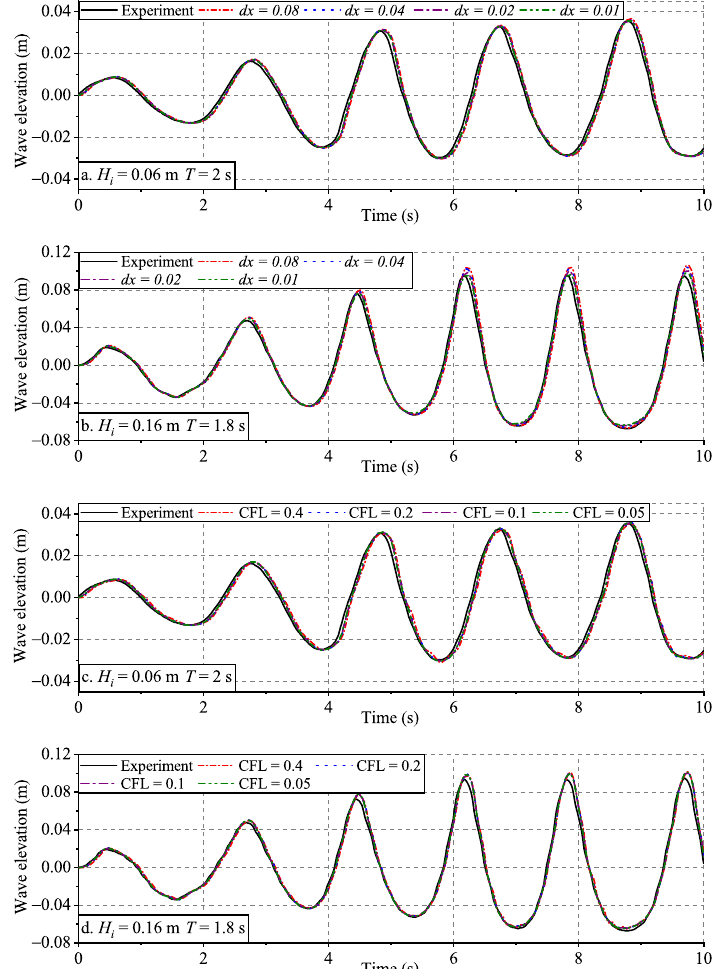
Figure 5. Influence of grid size ( dx ) and CFL number on reconstruction of monochromatic wave sur- face. ( a ) H i = 0.06 m, T = 2 s and CFL = 0.1, ( b ) H i = 0.16 m, T = 1.8 s and CFL = 0.1, ( c ) H i = 0.06 m, T = 2 s and dx = 0.02 m, ( d ) H i = 0.16 m, T = 1.8 s and dx = 0.02